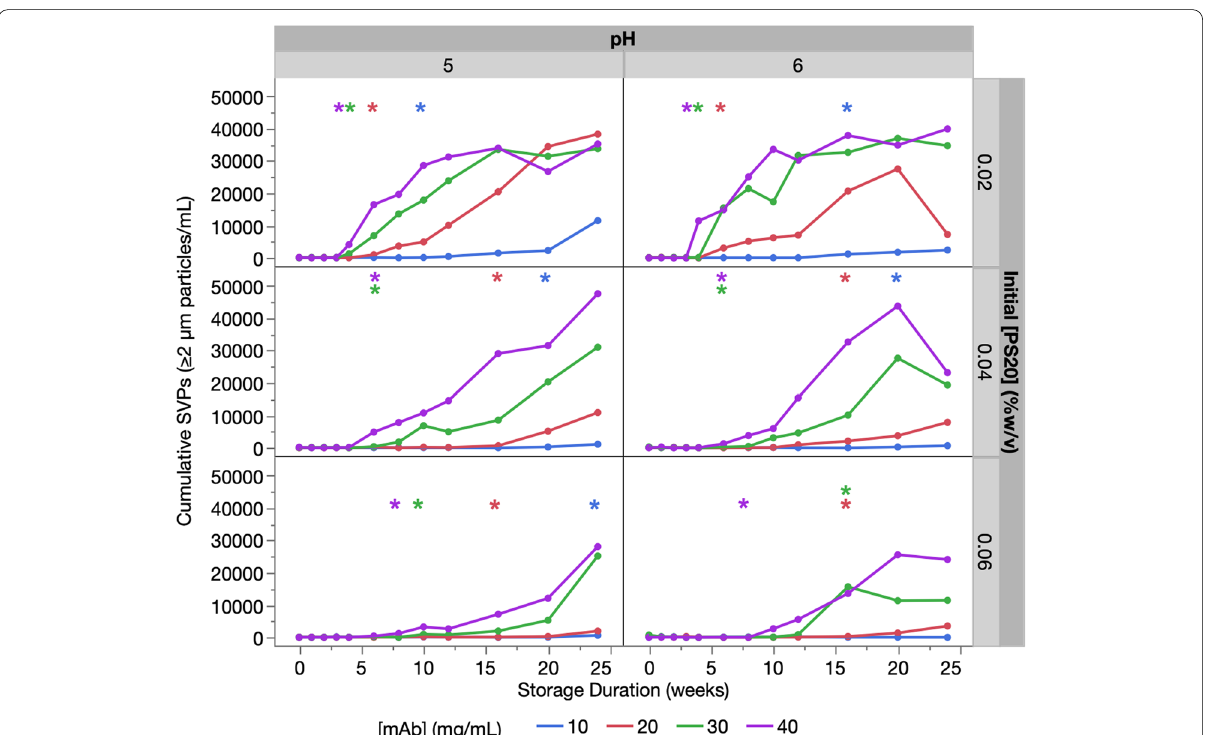
Fig. 3 Cumulative SVP counts ( 2 µm particles/mL) measured in mAb X DP over storage duration (weeks at 5 °C). Three formulation parameters— ≥ [mAb], initial [PS20], and pH—were assessed for their impact on SVP accumulation as measured by HIAC liquid particle counter. The 24 formulations and their VP outcomes are detailed in Table 1. Colored asterisks in the plots denote the earliest time points at which VPs were observed for the formulation (with corresponding [mAb] represented by the same